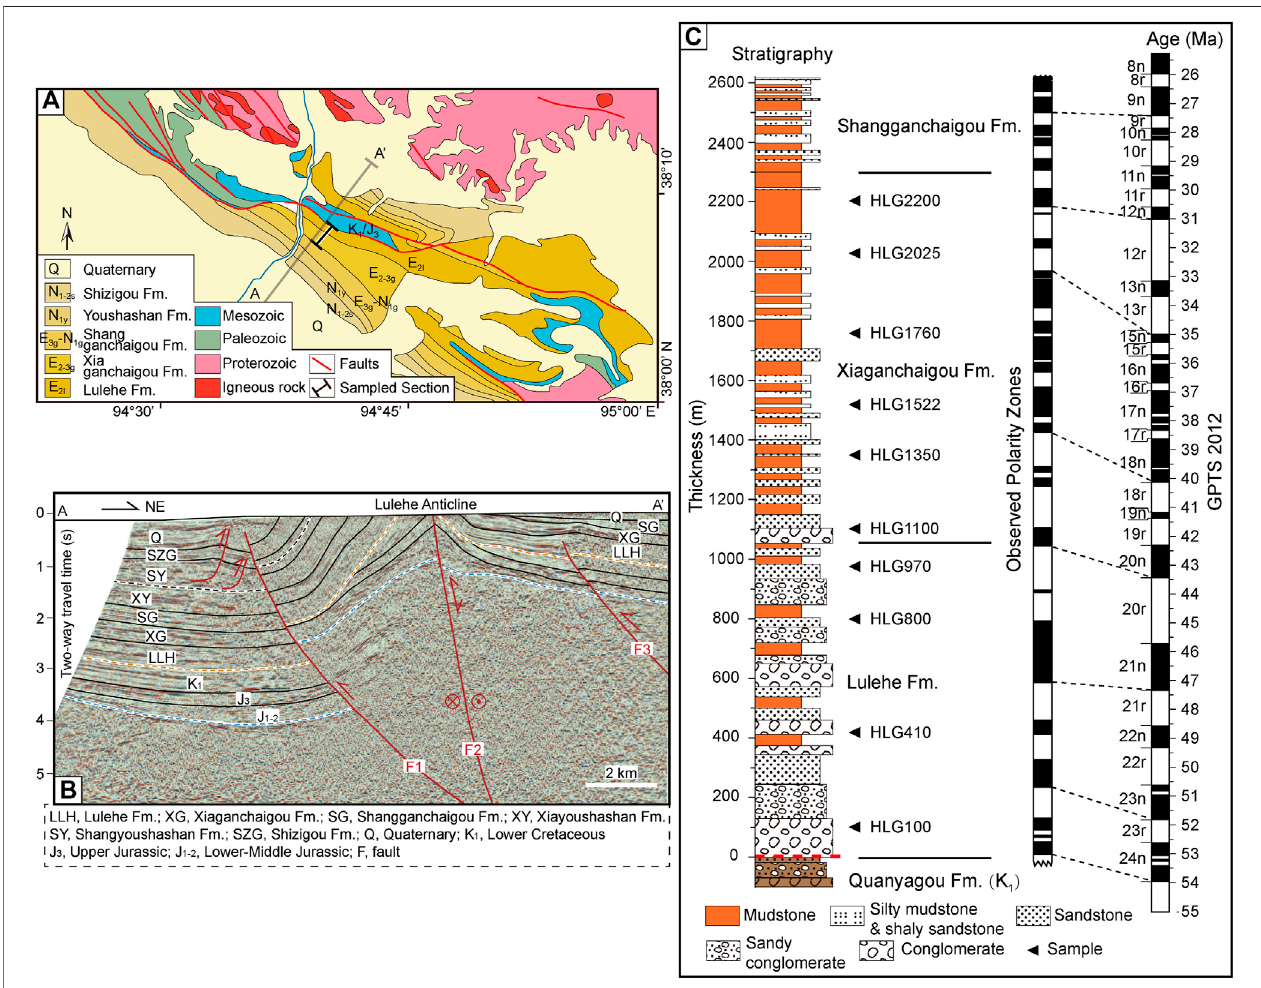
FIGURE 2 | Stratigraphy, lithology, and geochronology of the sampled section. (A) Geologic map of the HLG section and its vicinity (modi fi ed from Zhang, 2006). Locations of the sampled section ( Figure 2C ) and the seismic pro fi le ( Figure 2B ) are labelled. (B) Seismic pro fi le with geological interpretations across the HLG area (Zhangetal.,2020). (C) Stratigraphiccolumnandmagnetostratigraphy(Fangetal.,2019)ofthesampledstratawithdetailedAFTsamplepositions.GPTS:geomagnetic polarity time scale.